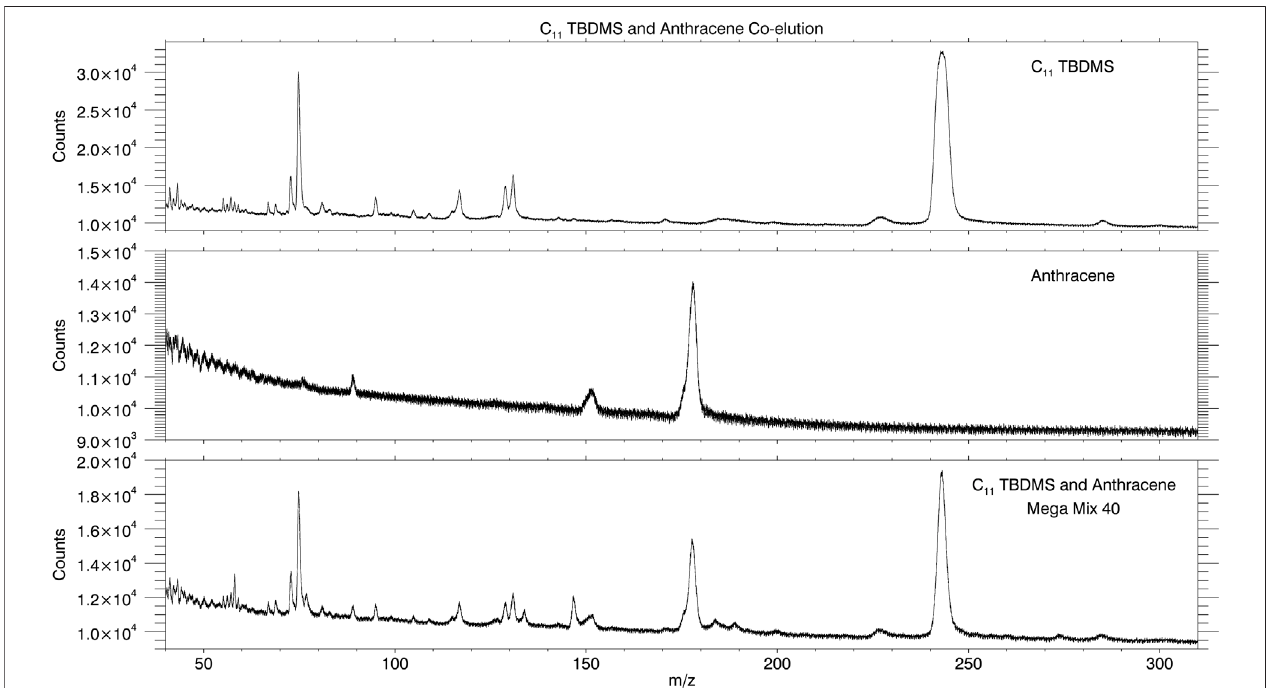
FIGURE6 | Mass spectrum ofC 11 TBDMS (top plot) taken from themixture offatty acid TBDMS (individual chemical familyrun) and massspectrum ofanthracene (middle plot) taken from the mixture of PAHs (individual chemical family run). Mass spectral features of both analytes are present in the single chromatographic peak of Mega Mix 40 con fi rming